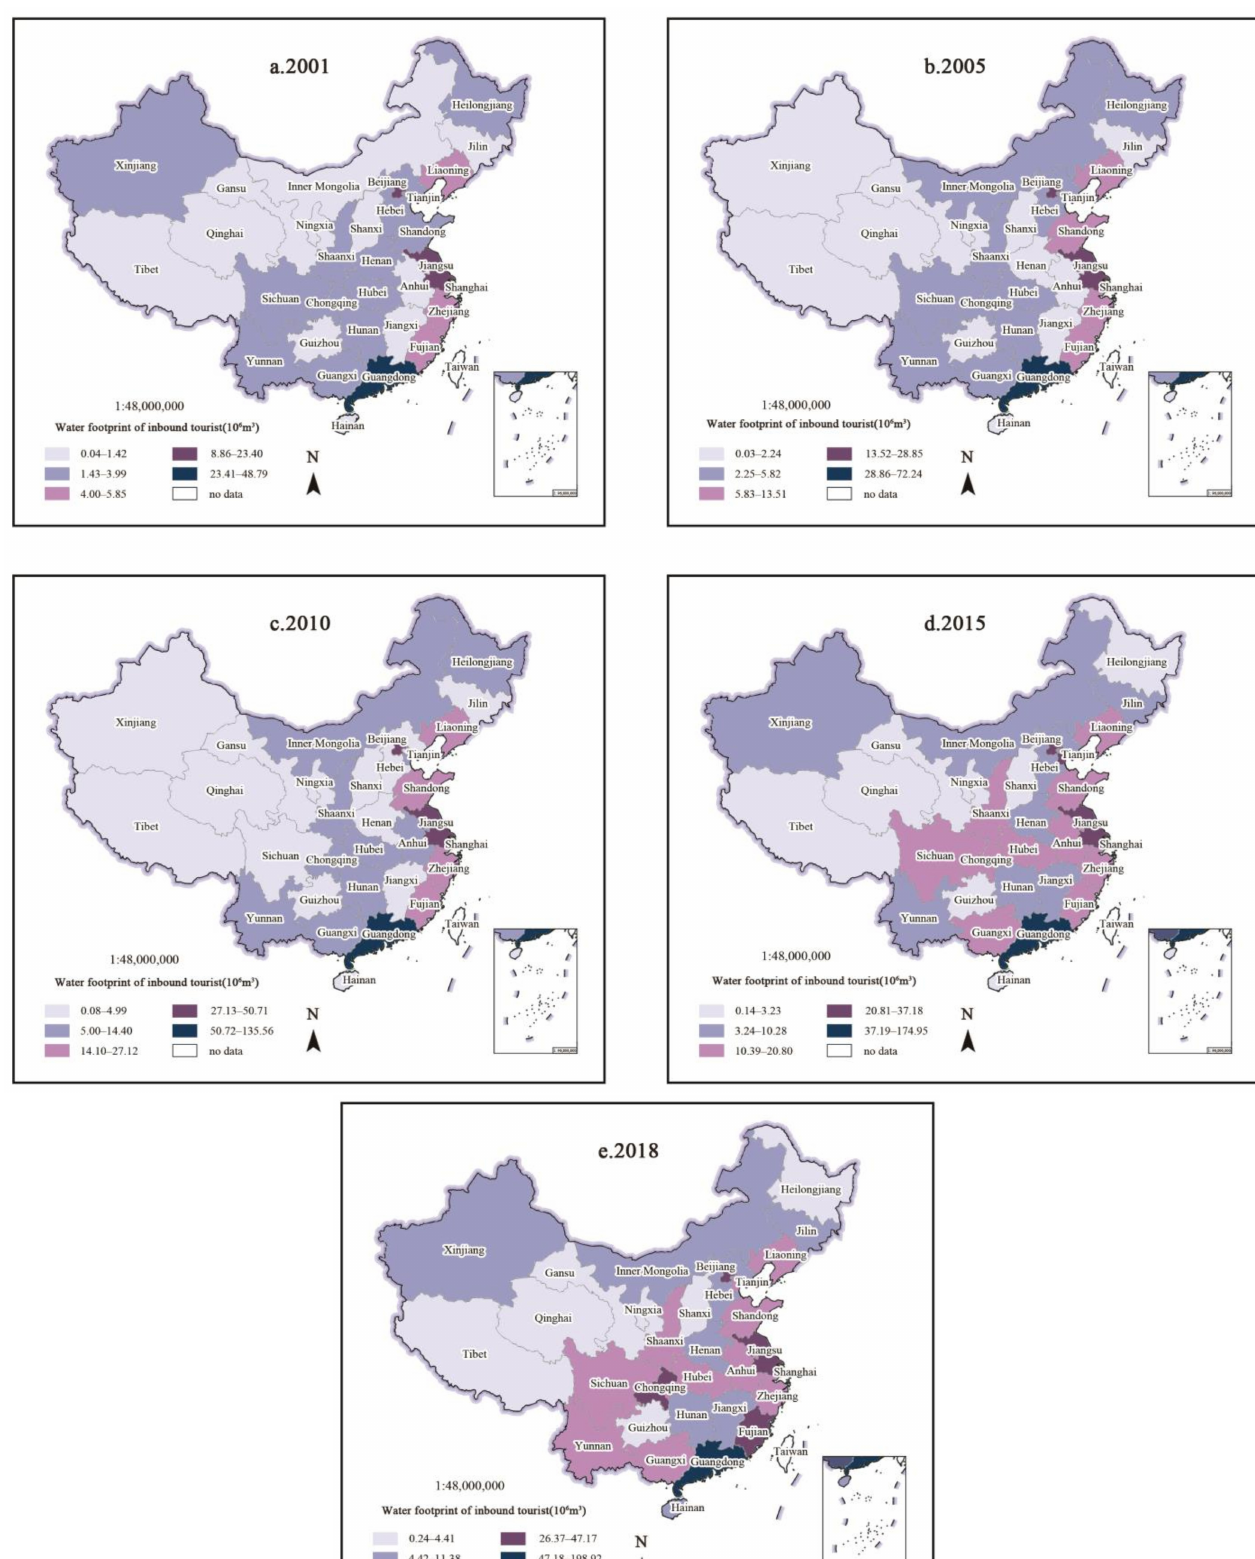
Figure 3. Spatial-temporal evolution pattern of water footprint of inbound tourists from 2001 to